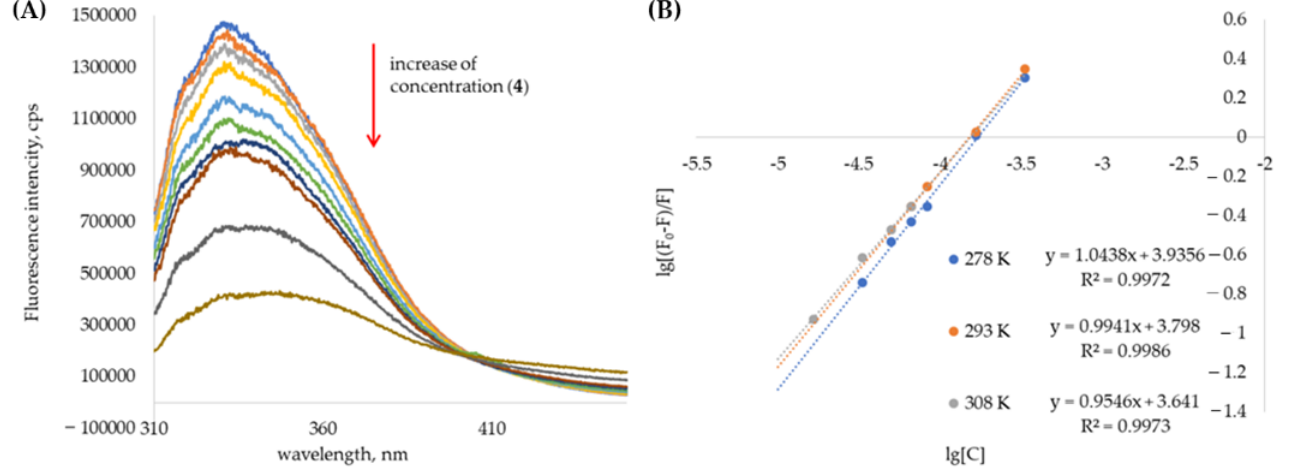
Figure 3. ( A ) Fluorescence spectra of BSA in the presence of 4 at 20 °C; ( B ) the graphs are plotted in the linearization of Stern–Volmer coordinates for 4 /BSA system.